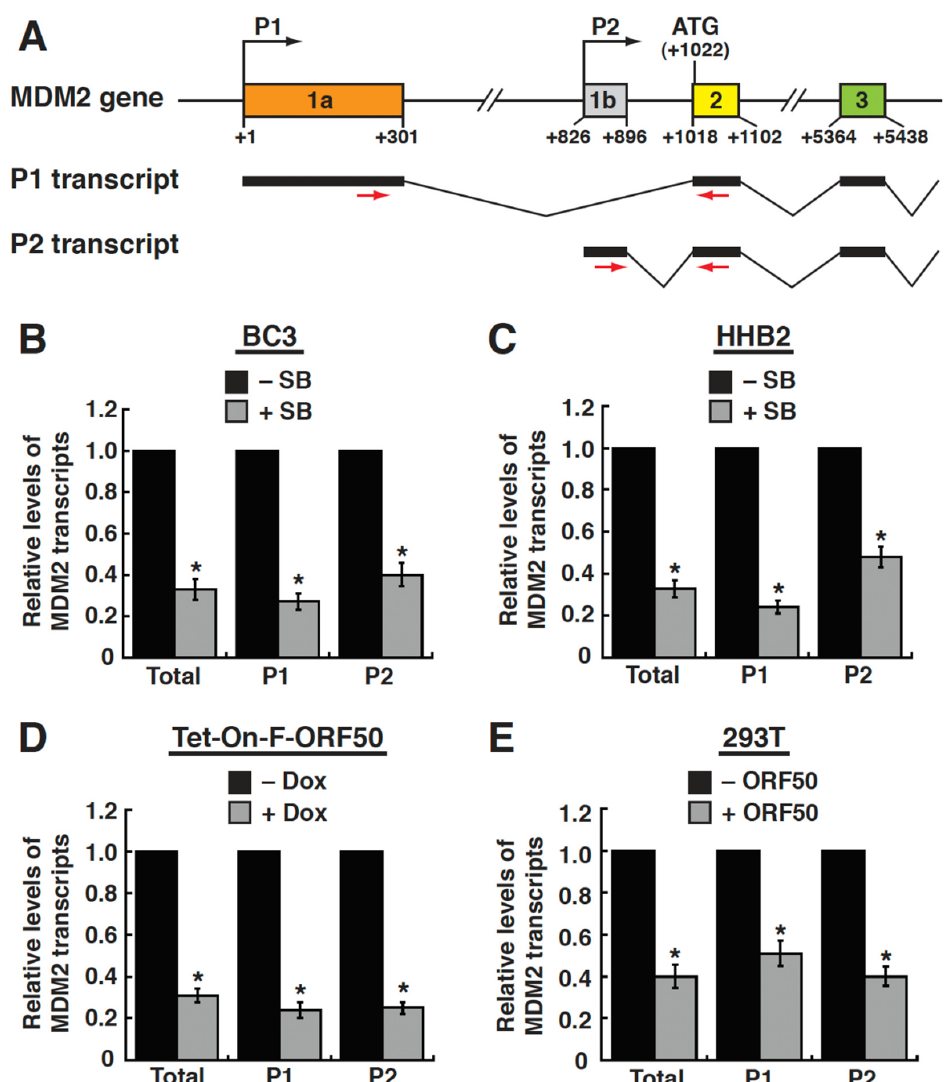
Figure 3. ORF50 represses both the P1 and P2 promoters of the MDM2 gene. ( A ) Schematic diagram of the P1 and P2 promoter regions of the MDM2 gene. The color boxes in the diagram indicate exons,